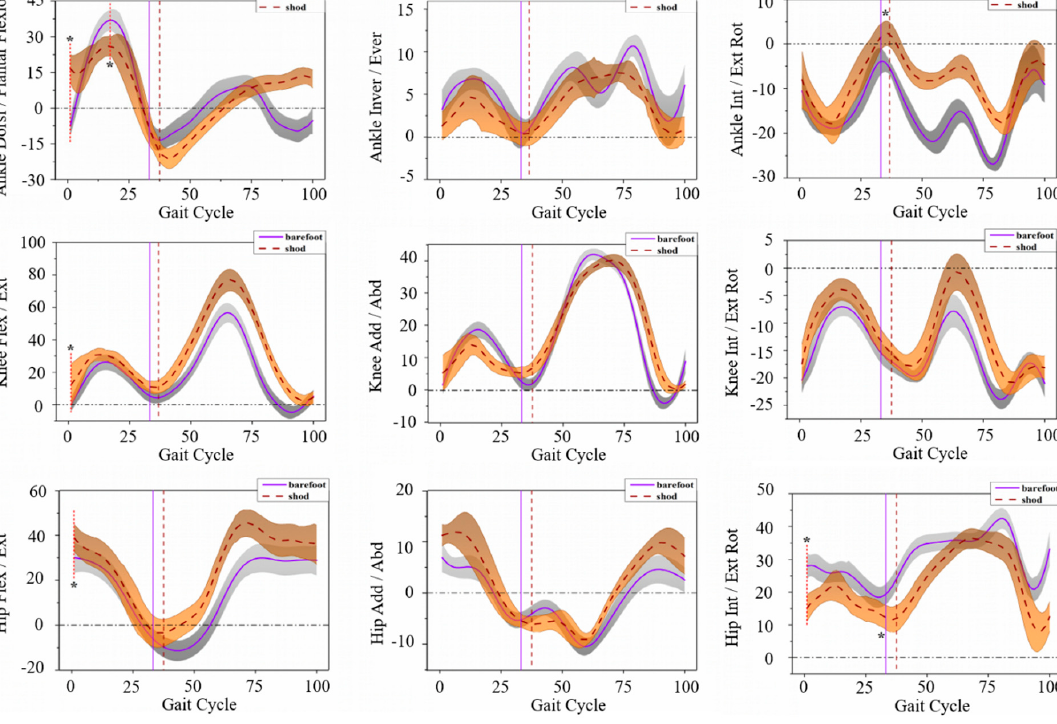
Figure 2. Joint angles curves of the ankle, knee, and hip in sagittal, frontal, and horizontal planes during one gait cycle. Red dotted lines with * indicate a significant difference, p < 0.05.